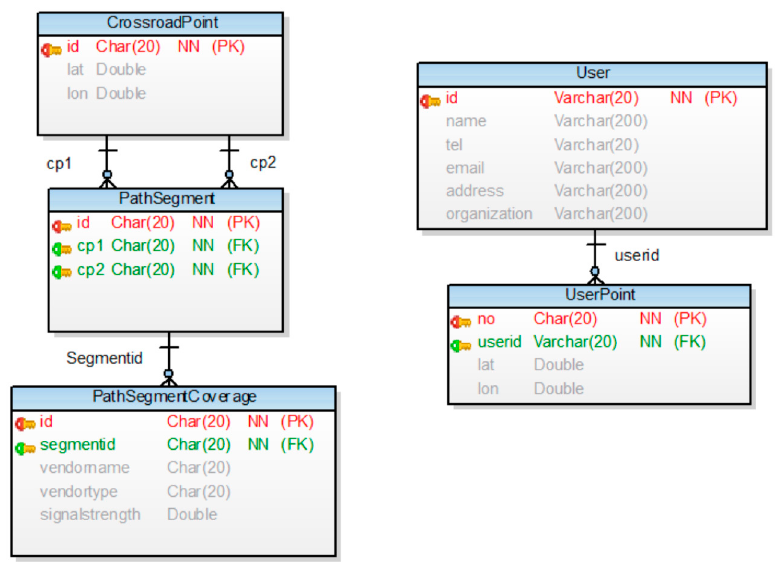
Figure 8. Data model of network coverage-based path prediction.